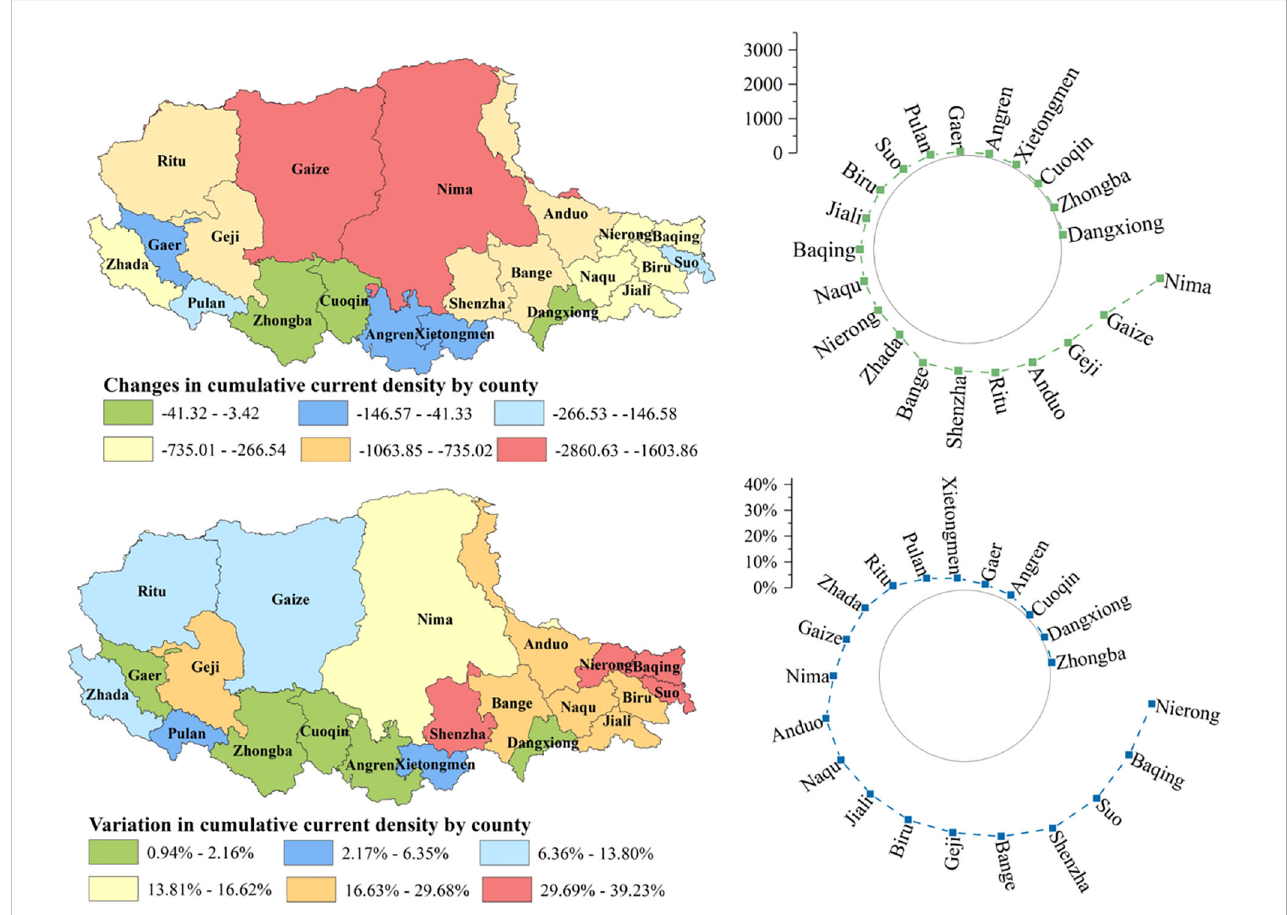
FIGURE 9 Changes in cumulative current density in each county due to fencing